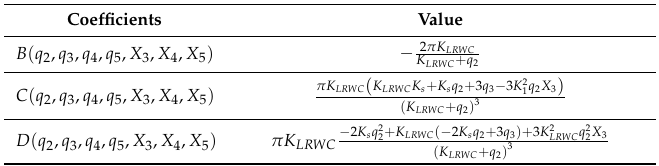
Table 1. Coefficients for different